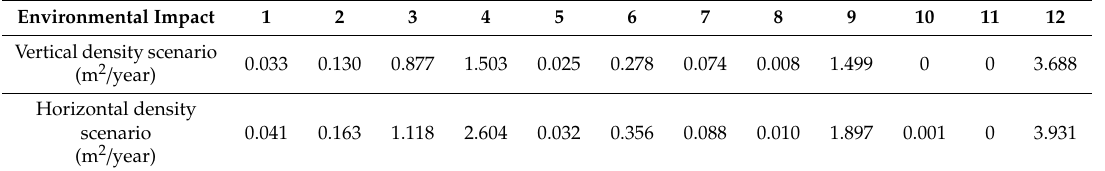
Table 10. Vertical and horizontal density scenarios.